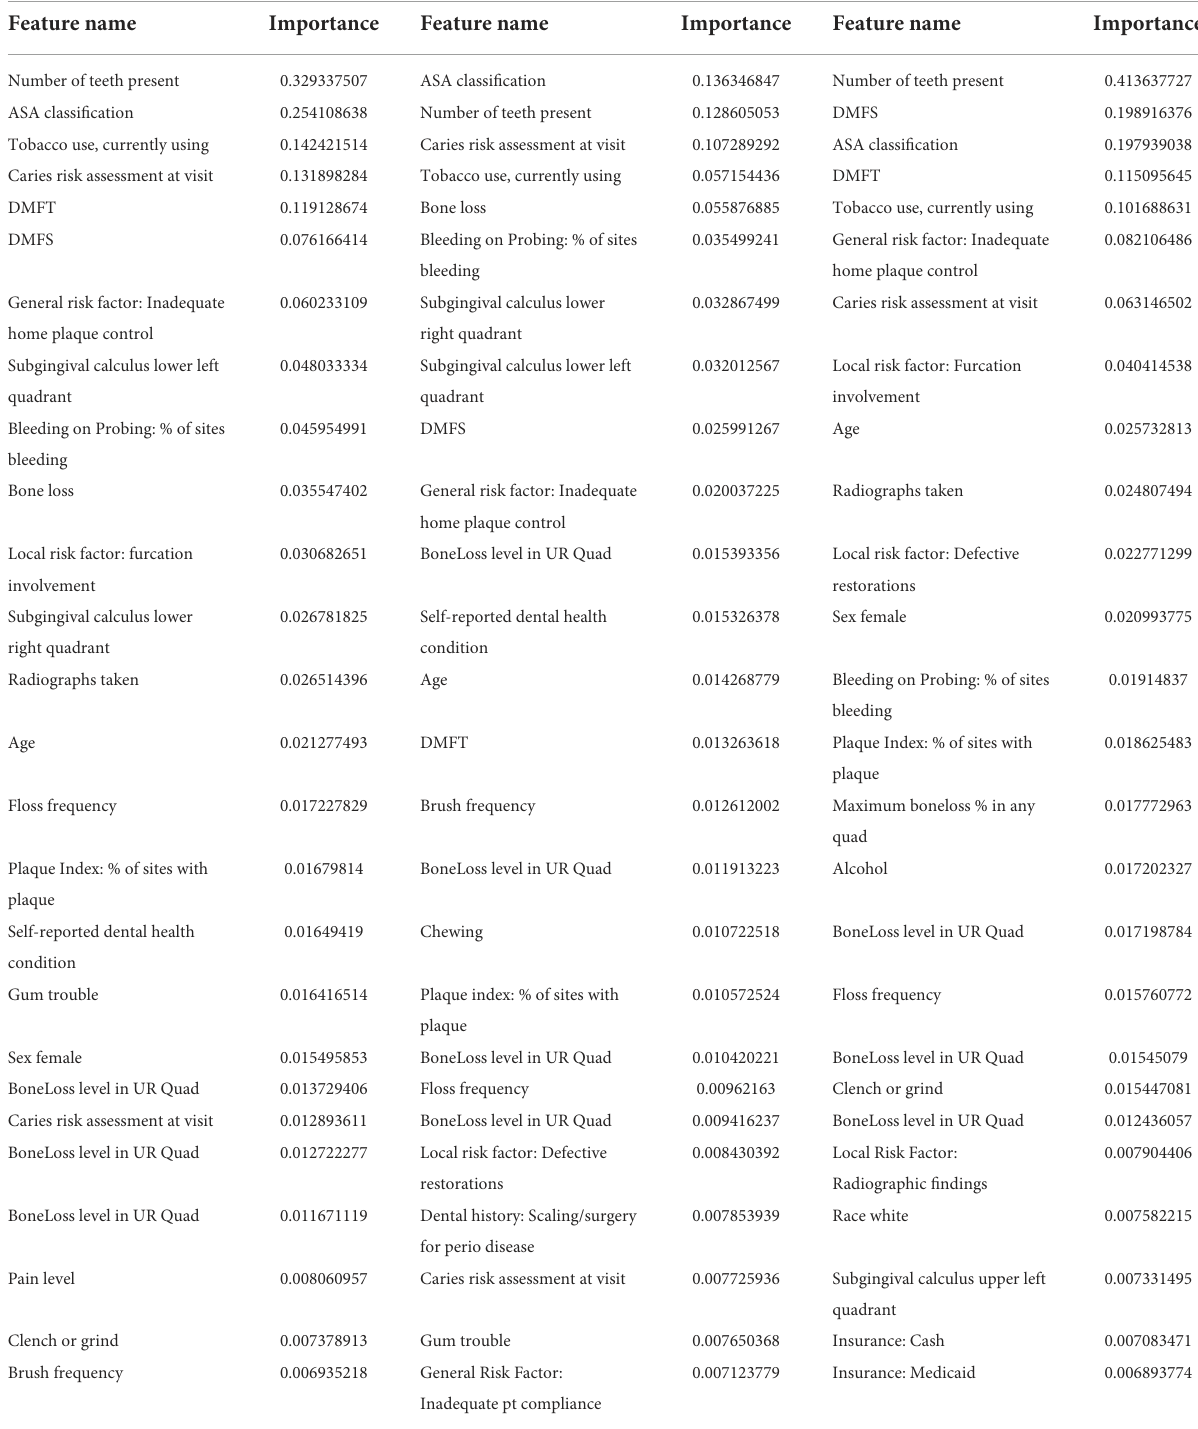
TABLE 6 Details of predictors of each base one- vs. -rest model. Healthy vs. others (PD) Mild vs. others Severe vs.